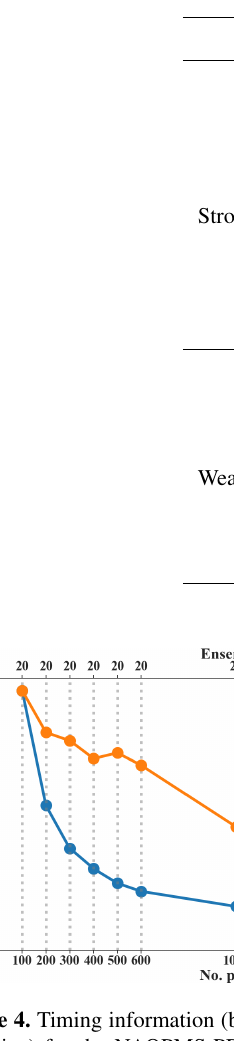
Figure 5. Timing information for the NAQPMS-PDAF for a weak scaling test. The blue line shows the execution time for initializa- tion. The orange line shows the execution time for model integra- tion. The green line shows the execution time for assimilation. The red line shows the execution time for finalization. A total of 50 pro- cessors are apportioned to each ensemble